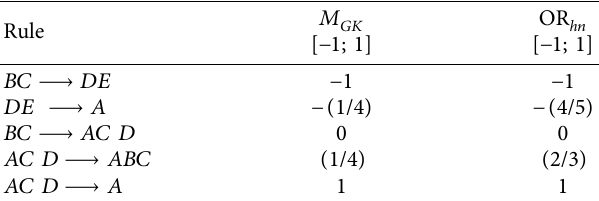
Table 5: The values taken for the quality measures M for some of the association rules considered.